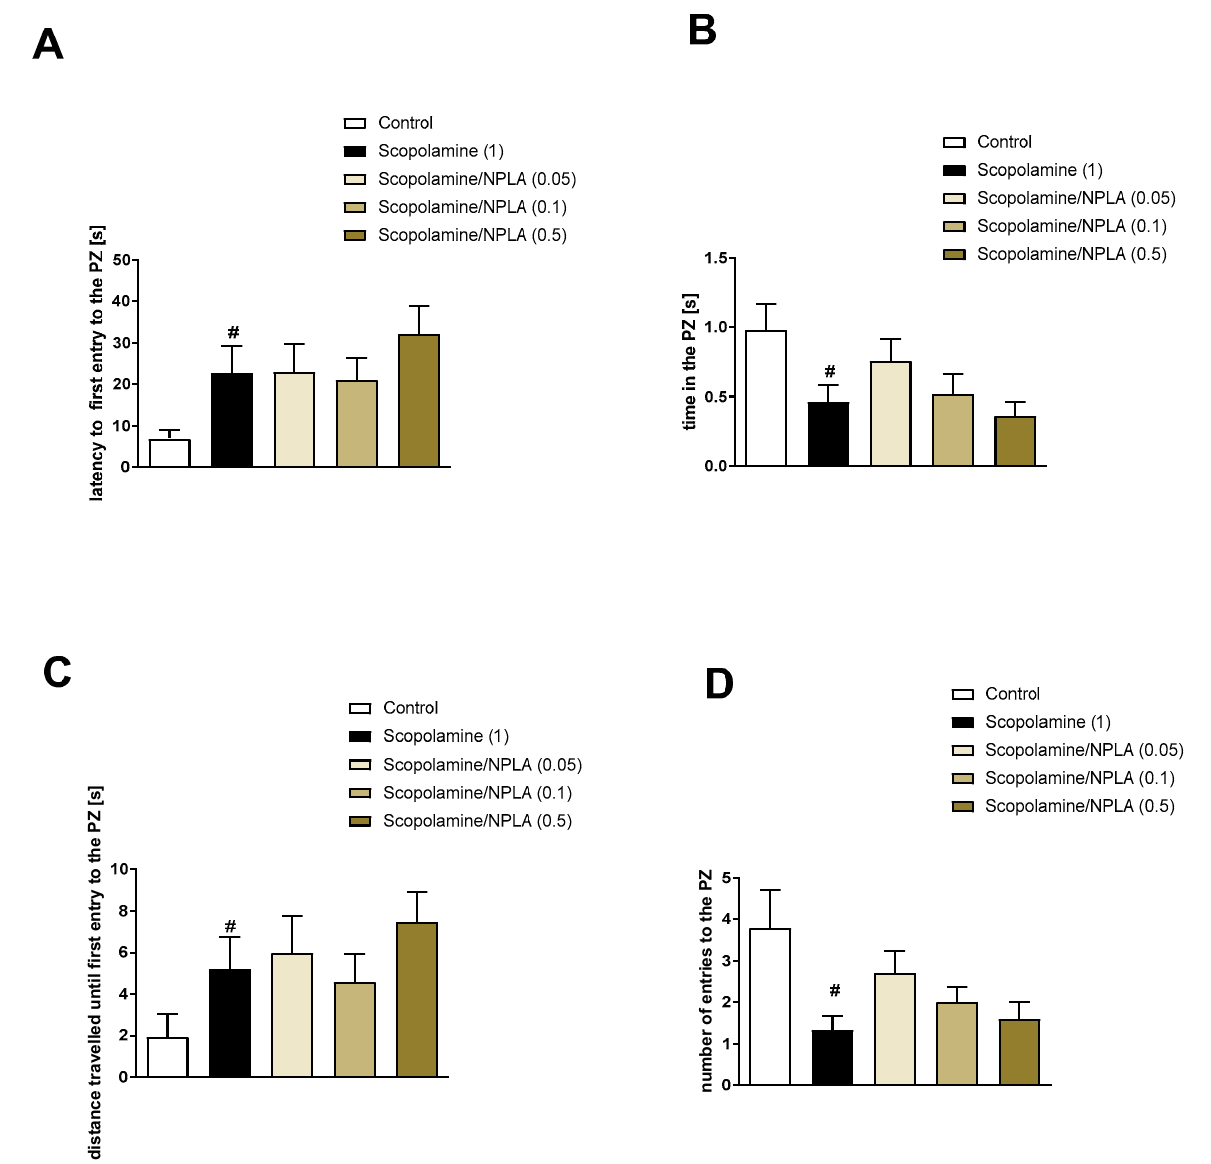
Figure 13. The effects of NPLA on scopolamine-induced deficits in the retention of spatial memory in the MWM of CD1 mice. PZ-related parameters. ( A ) the latency to the first entry into the PZ, ( B ) the time in the PZ, ( C ) the distance travelled in the PZ, ( D ) the number of entries into the PZ. The values are expressed as the means ± SEM. # p < 0.001 vs. control group (N = 7–9). The impact of MK-801 administration was observed in the number of entries into the PZ (t = 2.86; df = 47; p < 0.006) and the time spent in the PZ (t = 2.2; df = 47; p < 0.03). Analysis of the MK-801-induced behaviours revealed no activity of the selected compounds on PZ-related activities (Figure 14). Spermine NONOate: number of entries into the PZ [F (3.28) = 1.59, p = 0.2], the time in the PZ [F (3.28) = 0.46, p = 0.7]; DETA NONOate: the number of entries into the PZ [F (3.28) = 0.55, p = 0.64], the time in the PZ [F (3.28) = 1.68, p = 0.19]; and NPLA: the number of entries into the PZ [F (3.28) = 1.32, p = 0.28], the time in the PZ [F (3.28) = 1.05, p = 0.36].